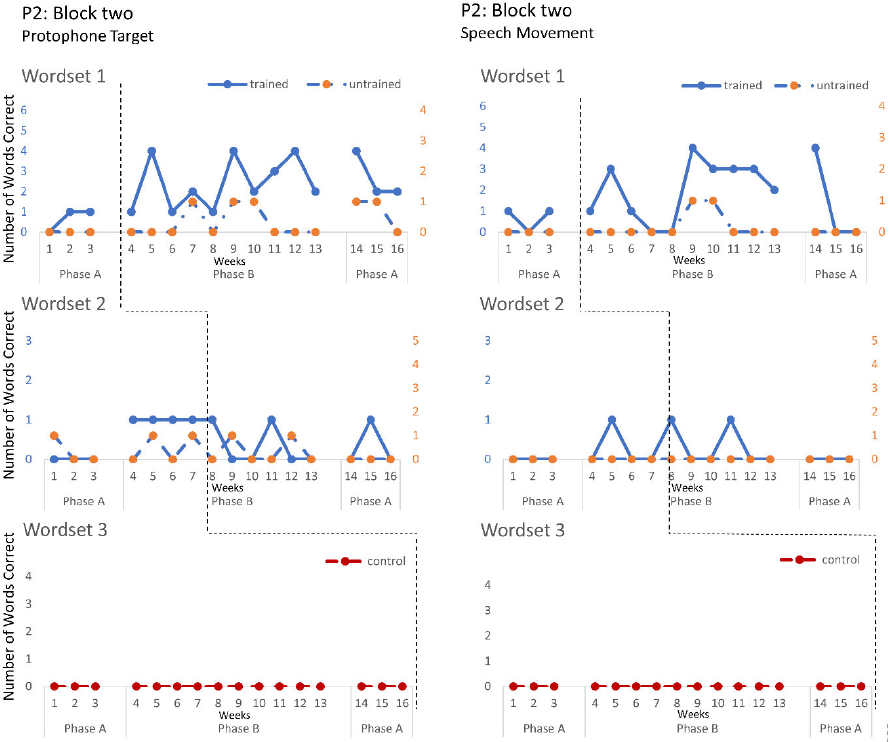
Figure 6. Accuracy of performance on the speech probes as scored for protophone target ( left ) and motor-speech movements ( right ) block two, participant 2.